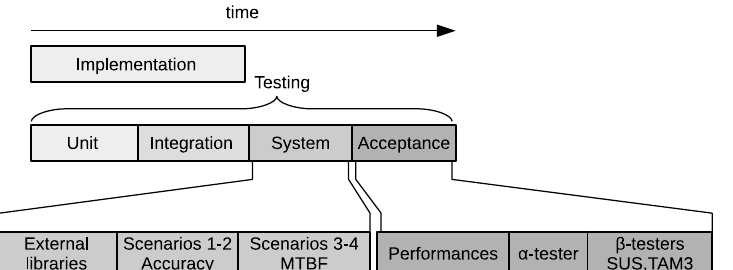
Figure 5. Methodology phases followed for software testing. During the implementation, the unit and integration phases were simultaneously accomplished. Then, in the system testing, the integration with external libraries and the evaluation of the library in different scenarios were carried out. Finally, the library performances were measured and sent to the α -tester who approved to proceed with the last part of the test in which some people ( β -testers) performed two programming exercises and filled in several surveys (SUS,